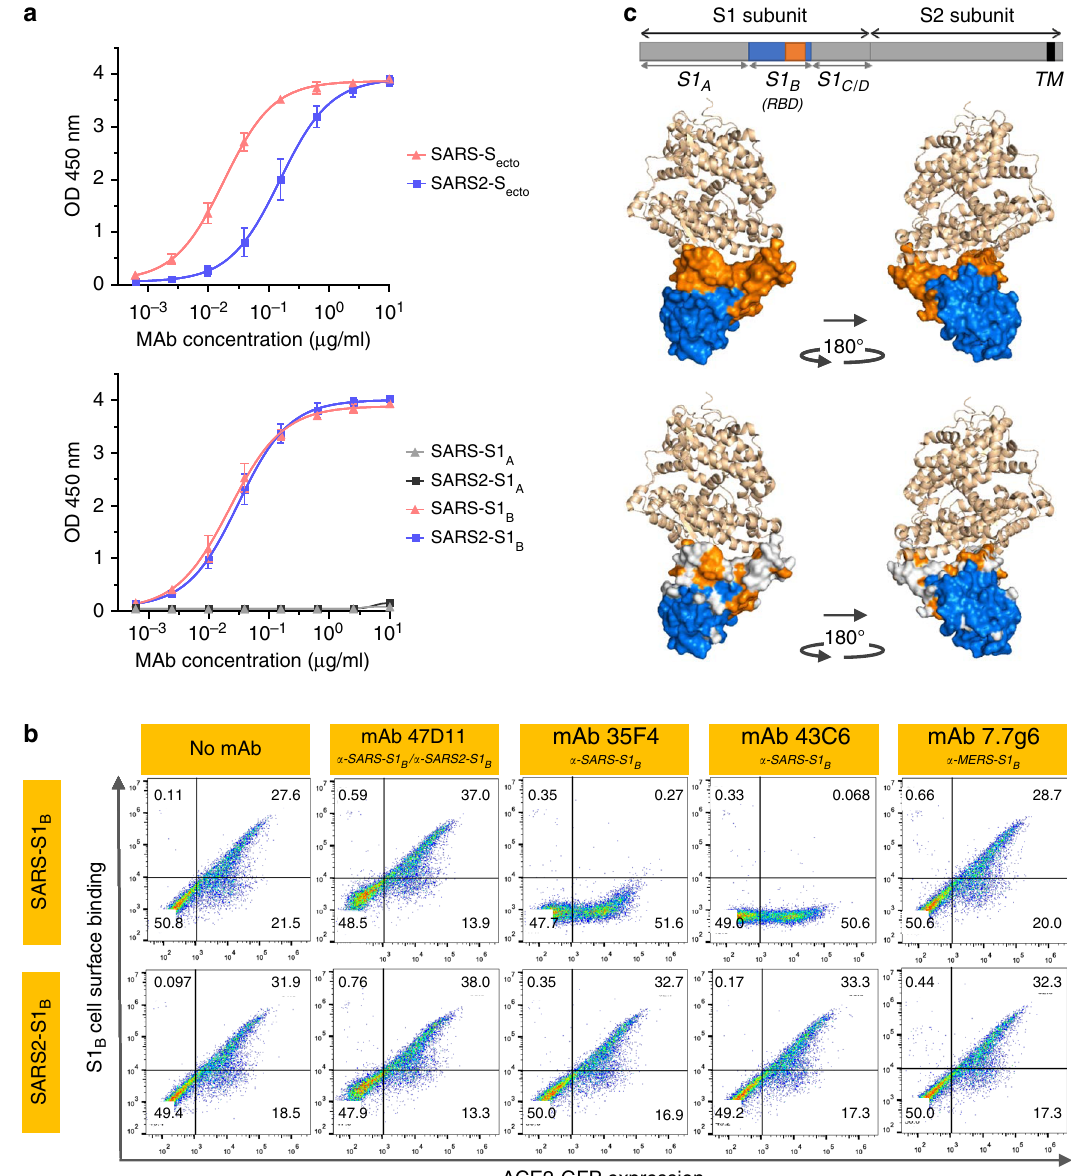
Fig. 2 The neutralizing 47D11 mAb binds SARS1-S and SARS2-S RBD without eliminating receptor interaction. a ELISA-binding curves of 47D11 to S ecto (upper panel) or S1 A and S1 B (RBD: receptor-binding domain) (lower panel) of SARS-S and SARS2-S coated at equimolar concentrations. The average ± SD from two independent experiments with technical duplicates is shown. b Interference of antibodies with binding of the S-S1 B of SARS-CoV and SARS-CoV- 2 to cell surface ACE2-GFP analyzed by fl ow cytometry. Prior to cell binding, S1 B was mixed with mAb (mAbs 47D11, 35F4, 43C6, 7.7G6, in H2L2 format) with indicated speci fi city in a mAb:S1 B molar ratio of 8:1 (see Supplementary Fig. 3 for an extensive analysis using different mAb:S1 B molar ratio ’ s). Cells are analyzed for (ACE2-)GFP expression ( x axis) and S1 B binding ( y axis). Percentages of cells that scored negative, single positive, or double positive are shown in each quadrant. Experiment was done twice, a representative experiment is shown. c Divergence in surface residues in S1 B of SARS-CoV and SARS-CoV-2. Upper panel: Structure of the SARS-CoV spike protein S1 B RBD in complex with human ACE2 receptor (PDB: 2AJF) 24 . ACE2 (wheat color) is visualized in ribbon presentation. The S1 B core domain (blue) and subdomain (orange) are displayed in surface presentation using PyMOL, and are visualized with the same colors in the linear diagram of the spike protein above, with positions of the S1 and S2 subunits, the S ectodomain (S ecto ), the S1 domains S1 A-D and the transmembrane domain (TM) indicated. Lower panel: similar as panel above with surface residues on S1 B of SARS-CoV that are at variance with SARS-CoV-2 colorored in white. Source data are provided as a Source Data fi possibly also other future emerging diseases in humans caused by Q696P8) were expressed transiently in HEK-293T cells with a C-terminal tri- merization motif and Strep-tag using the pCAGGS expression plasmid. Similarly, viruses from the Sarbecovirus subgenus. pCAGGS expression vectors encoding S1 or its subdomains of SARS-CoV (S1, residues 1 – 676; S1 A , residues 1 – 302; S1 B , residues, 325 – 533), and SARS-CoV-2 (S1, Methods residues 1 – 682; S1 A , residues 1 – 294; S1 B , residues 329 – 538) C-terminally tagged with Fc domain of human or mouse IgG or strep-tag were generated as described Expression and puri fi cation of coronavirus spike proteins . Coronavirus spike before 21 . Coronavirus spike ectodomain of MERS-CoV (residues 19 – 1262; strain ectodomains (S ecto ) of SARS-CoV-2 (residues 1 – 1213; strain Wuhan-Hu-1; Gen- EMC; GenBank: YP_009047204.1) and SARS-CoV (residues 15 – 1182; strain Bank: QHD43416.1) and HCoV-OC43 (residues 15 – 1263; strain Paris; UniProtKB: